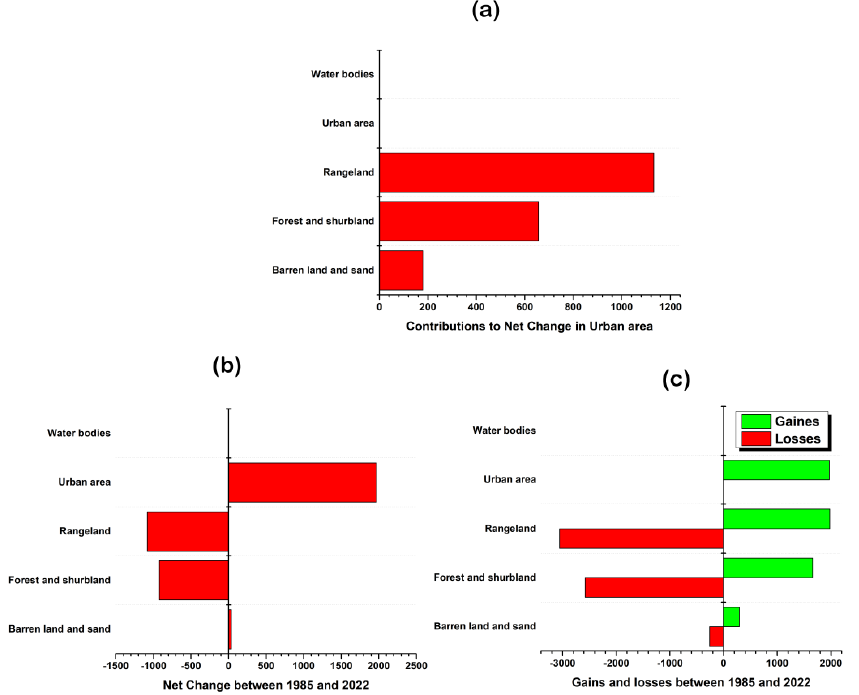
Figure 9. Results of ( a ) contribution to net change in urban area ( b ) net change and ( c ) gains and losses for land cover of ElBaha region between 1984 –